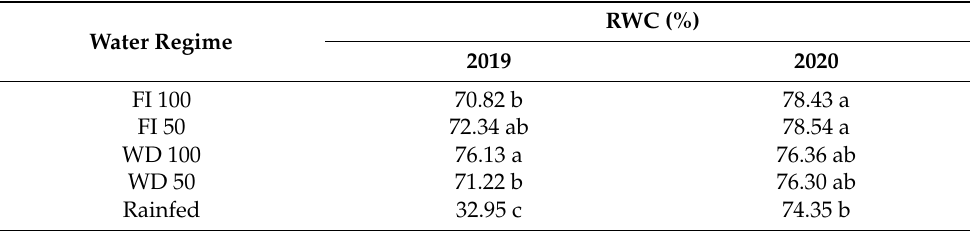
Figure 6. Photosynthetic rates of coffee leaves under water stress ( A , C) and after irrigation ( B , D ), in 2019 ( A , B ) and 2020 ( C , D ), of three arabica coffee genotypes (Iapar 59, Catuaí 62 and E237) under